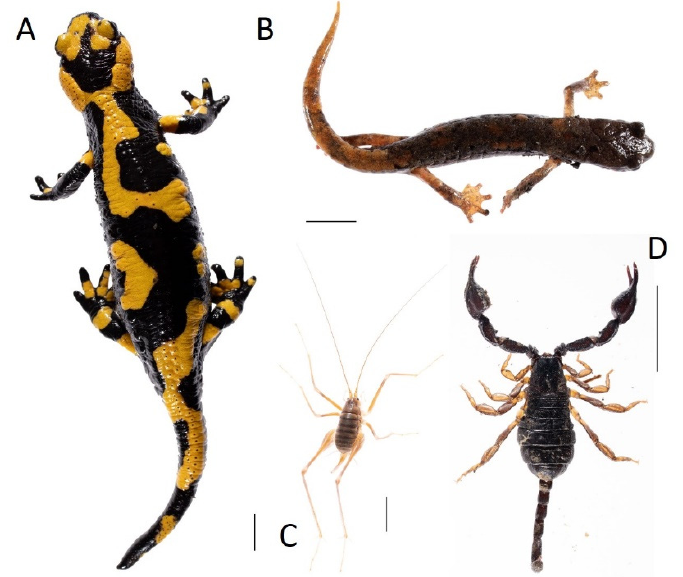
Figure 3. An example of picture obtained using our photographic set-up. ( A ) Salamandra salamandra ; ( B ) Speleomantes italicus ; ( C ) Dolichopoda ligustica ; ( D ) Euscorpius sp. Scale bars = 1 cm. These images were obtained in the wild using the described photographic set-up equipped with a Canon EOSR with the optic Canon RF 35 mm F1.8 Macro IS STM; flashes and triggers had the same settings as in this study (see Table 1).